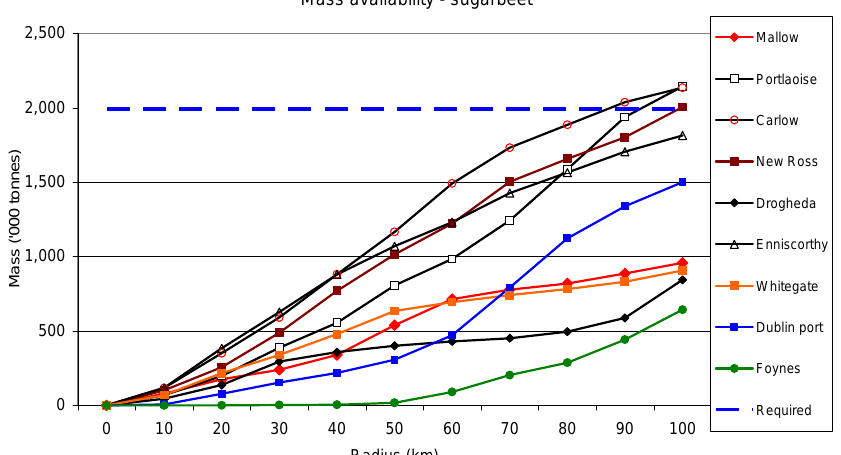
Figure 4. Modeled availability of sugarbeet around each location. Mass availability -